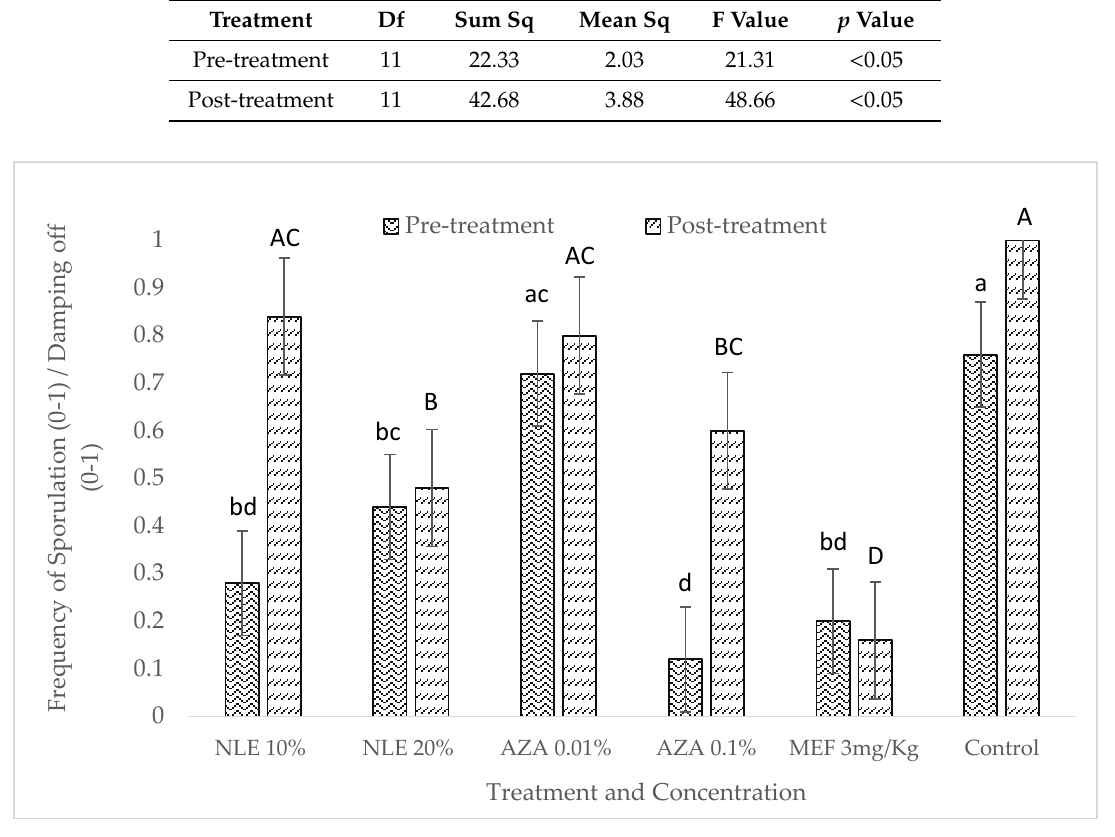
Figure 4. Pre- and Post-treatment effects of neem leaf extract (NLE) and NeemAzal T/S (AZA) on P. halstedii sporulation in susceptible sunflower seedlings. Different lowercase letters represent significant difference comparing the pre-treatment effect. Different uppercase letters represent significant difference to compare post-treatment effect according to Tukey’s test at 95% confidence level.